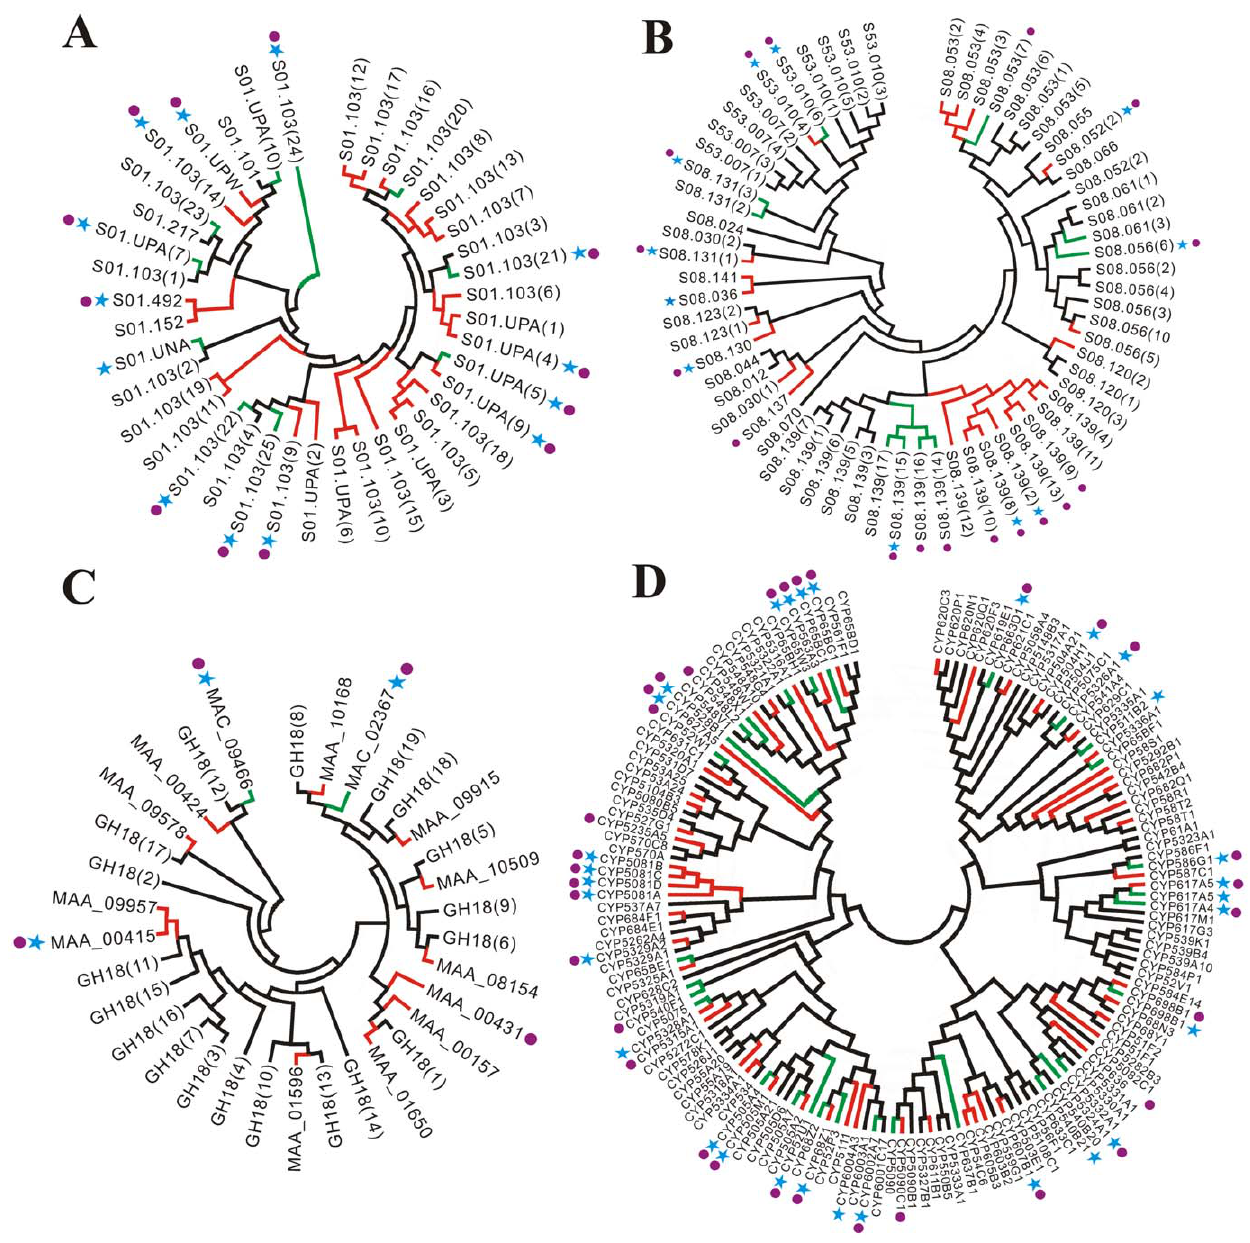
Figure 5. Unrooted phylogenetic trees showing differences in gene expansion in M.anisopliae and M.acridum. (A) Trypsins; (B) Subtilisins; (C) GH18 chitinases; (D) Cytochrome P450s. Black branches identify orthologous loci in M. anisopliae and M. acridum . Red and green branches identify genes that are only present in M. anisopliae or M. acridum , respectively. Lineage specific genes expressed by these species on cockroach cuticle are marked with a blue asterisk. Lineage specific genes expressed on locust cuticle are marked with a purple circle. Protease family classification refers to Table S7 for trypsins and Table S8 for subtilisins.